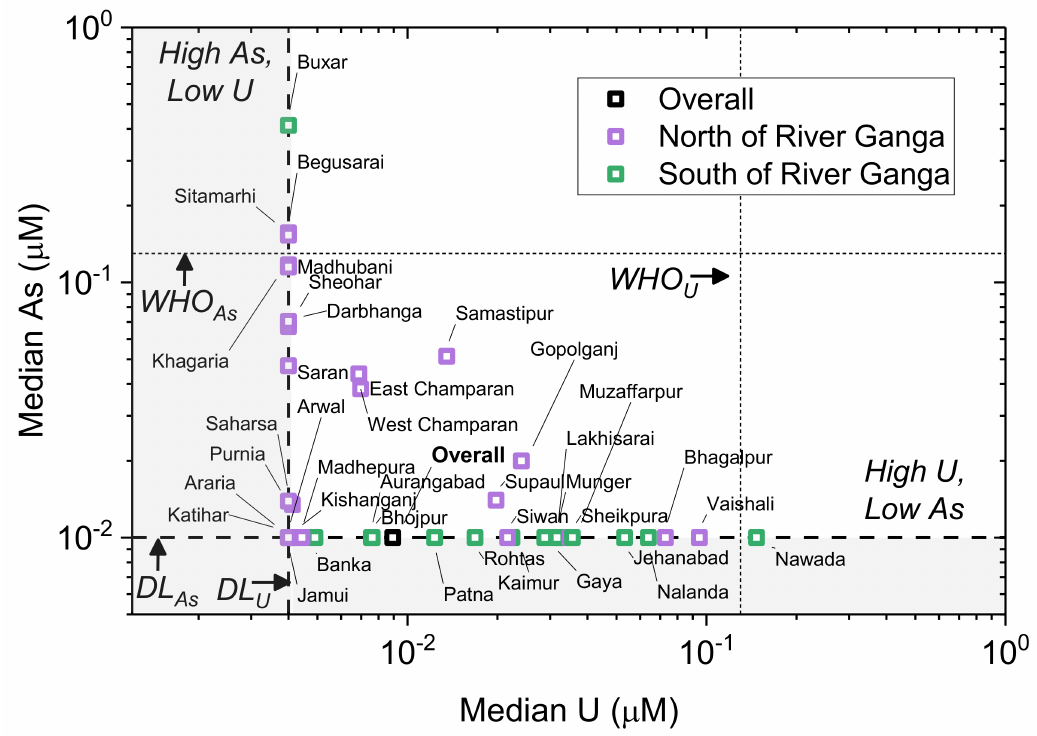
Figure 9. District-level median As versus median U in Bihar with district names labelled and geographic location (e.g., north versus south of Ganga River) indicated in colour. WHO provisional guidelines [4] for both As and U are shown in dotted lines (WHO); method detection limits (DL) for As and U are shown in dashed lines. Grey boxes indicate median concentrations below detection; districts with median concentrations of non-detection are presented at the value of the method detection limit to represent maximum (e.g., most conservative) concentration